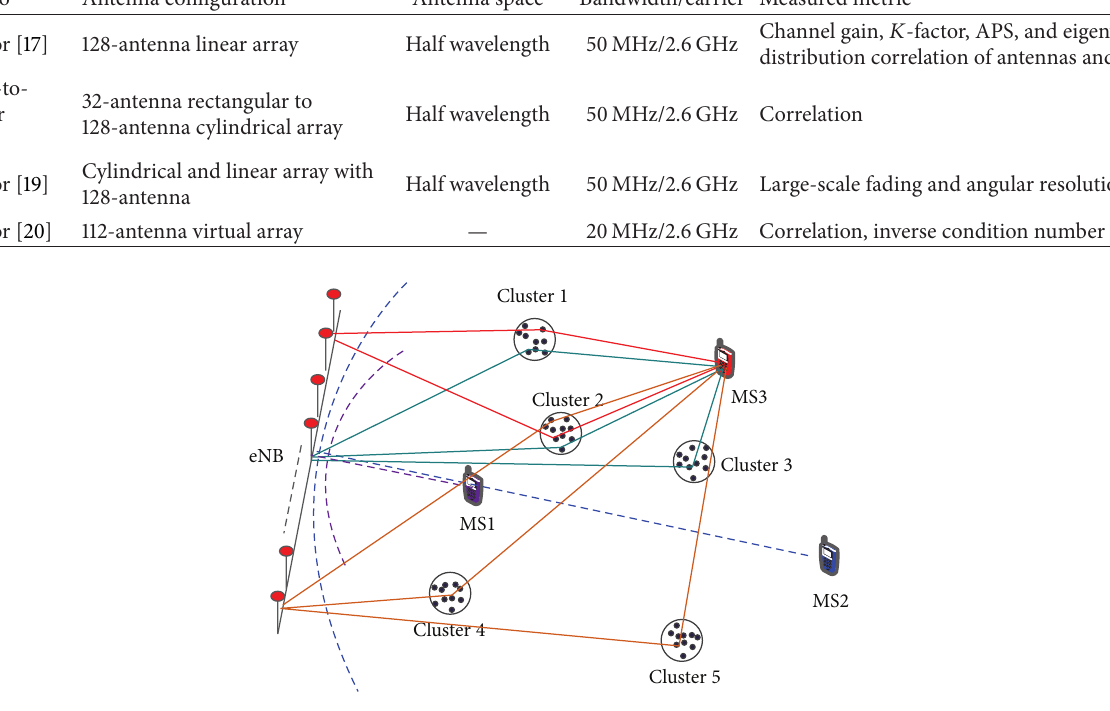
Figure 2: Illustration of nonstationary phenomenon and near-field effect